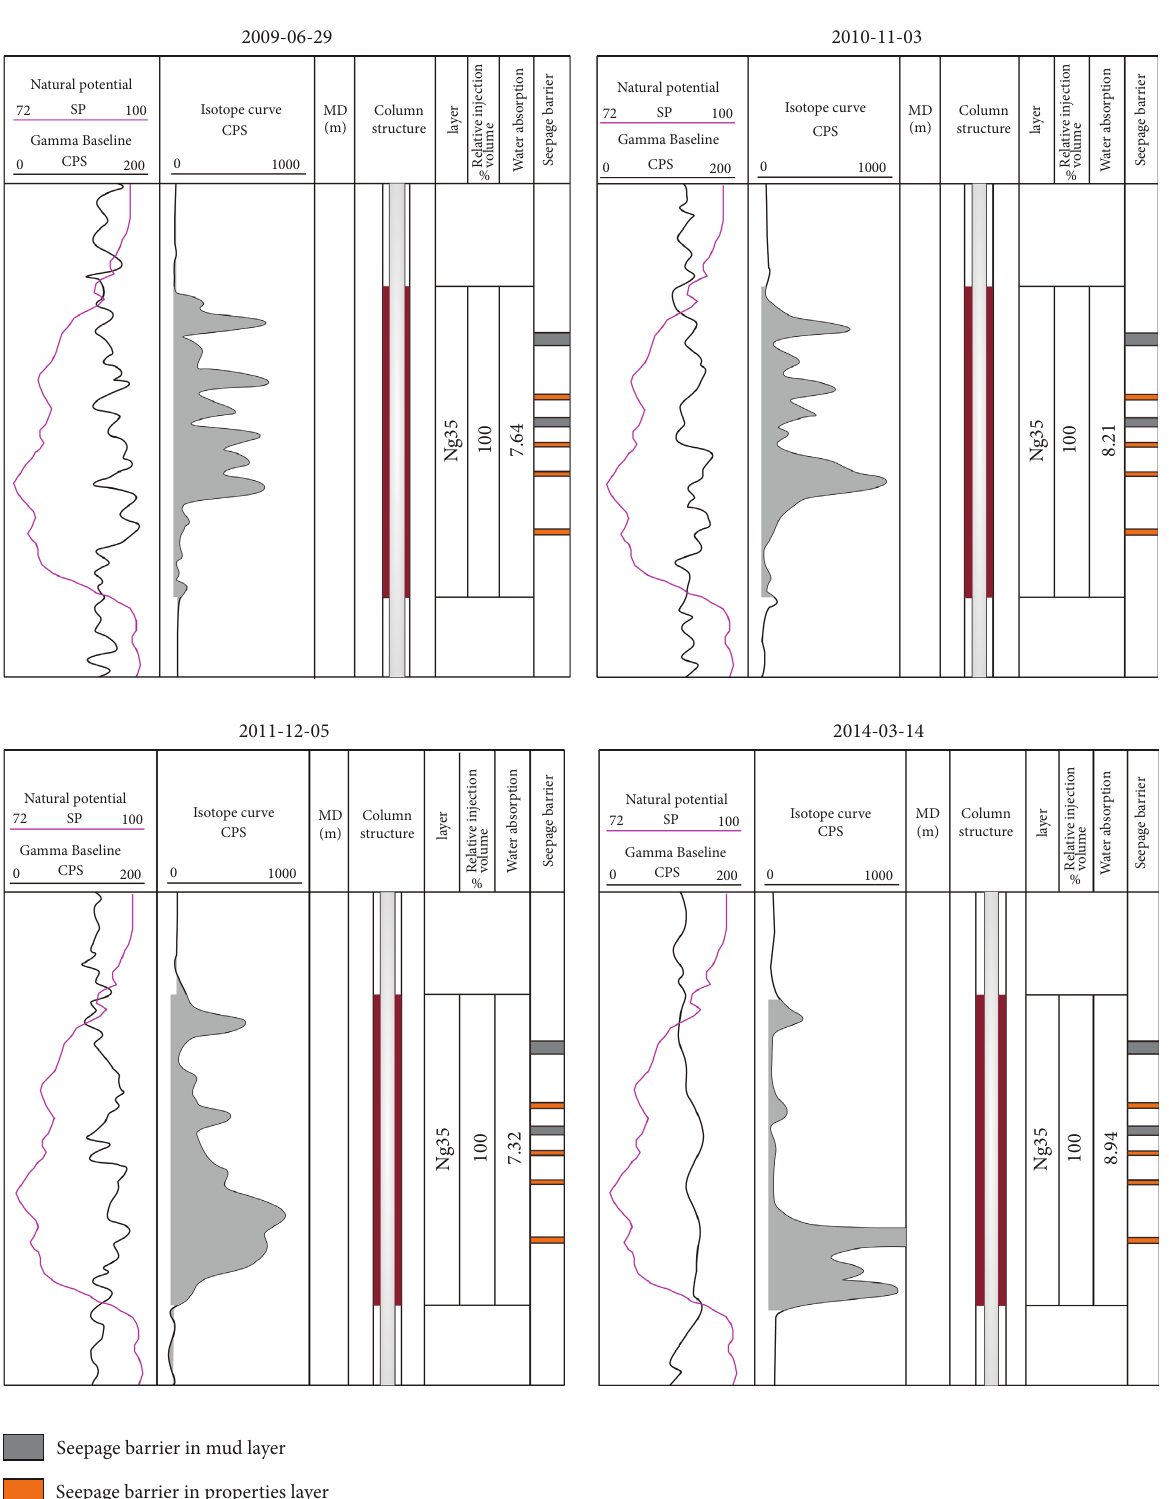
Figure 13: Comprehensive 3D characterization of multilevel seepage